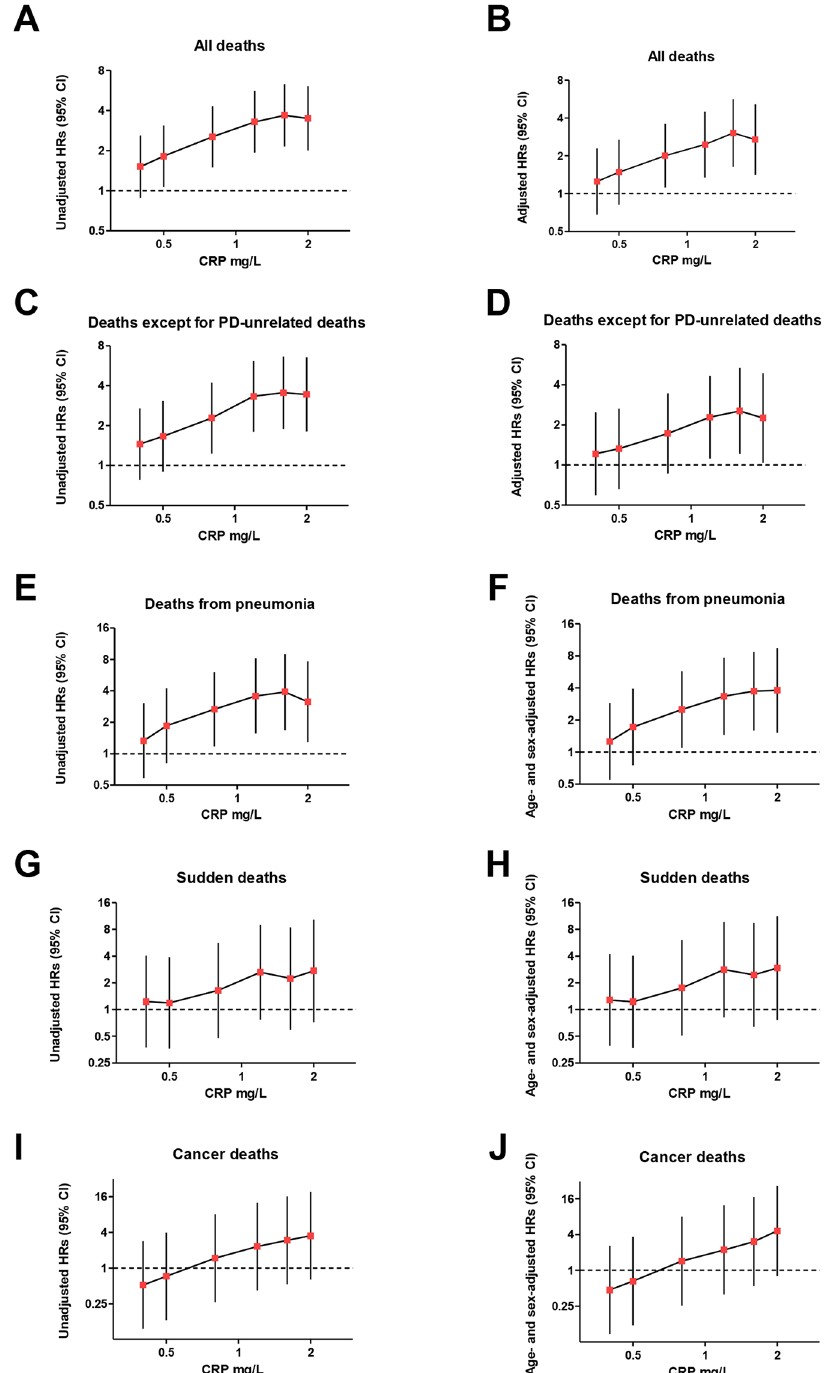
Fig 3. Relative risk of death by CRP concentration. Relative risk of death was estimated as hazard ratios (HRs) using Cox proportional hazard models. Unadjusted HRs of all deaths correlated with log CRP concentrations (A). To exclude possible confounders, HRs of all deaths were adjusted for age, sex, PD disease duration, MMSE ( (cid:1) 24 vs . > 24), mH-Y (1 – 3 vs . 4 – 5), and serum albumin levels, and the analysis showed a log-linear association with CRP concentrations (B). Similarly unadjusted and adjusted HRs of death, excluding PD-unrelated deaths, correlated with CRP concentrations (C, D). Unadjusted and age- and sex-adjusted HRs of deaths from pneumonia correlated with CRP concentrations (E, F). Unadjusted and age- and sex-adjusted HRs of sudden deaths correlated with CRP concentrations, although there was no